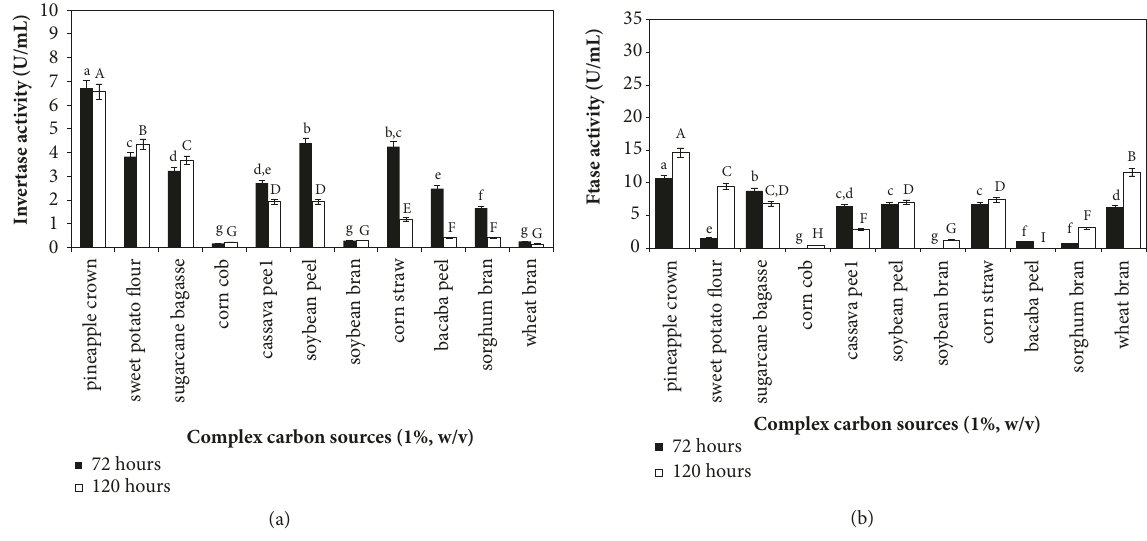
Figure 3: Complex carbon sources on invertase (a) and 𝛽 -D-fructosyltransferase (b) by black Aspergillus sp. PC-4. Culture conditions: complex carbon sources (1.0%, w/v), yeast extract (0.2% w/v), 28 ∘ C, 180 rpm. Mean values with the same letter do not statistically differ from each other by the ANOVA Tukey test (p =